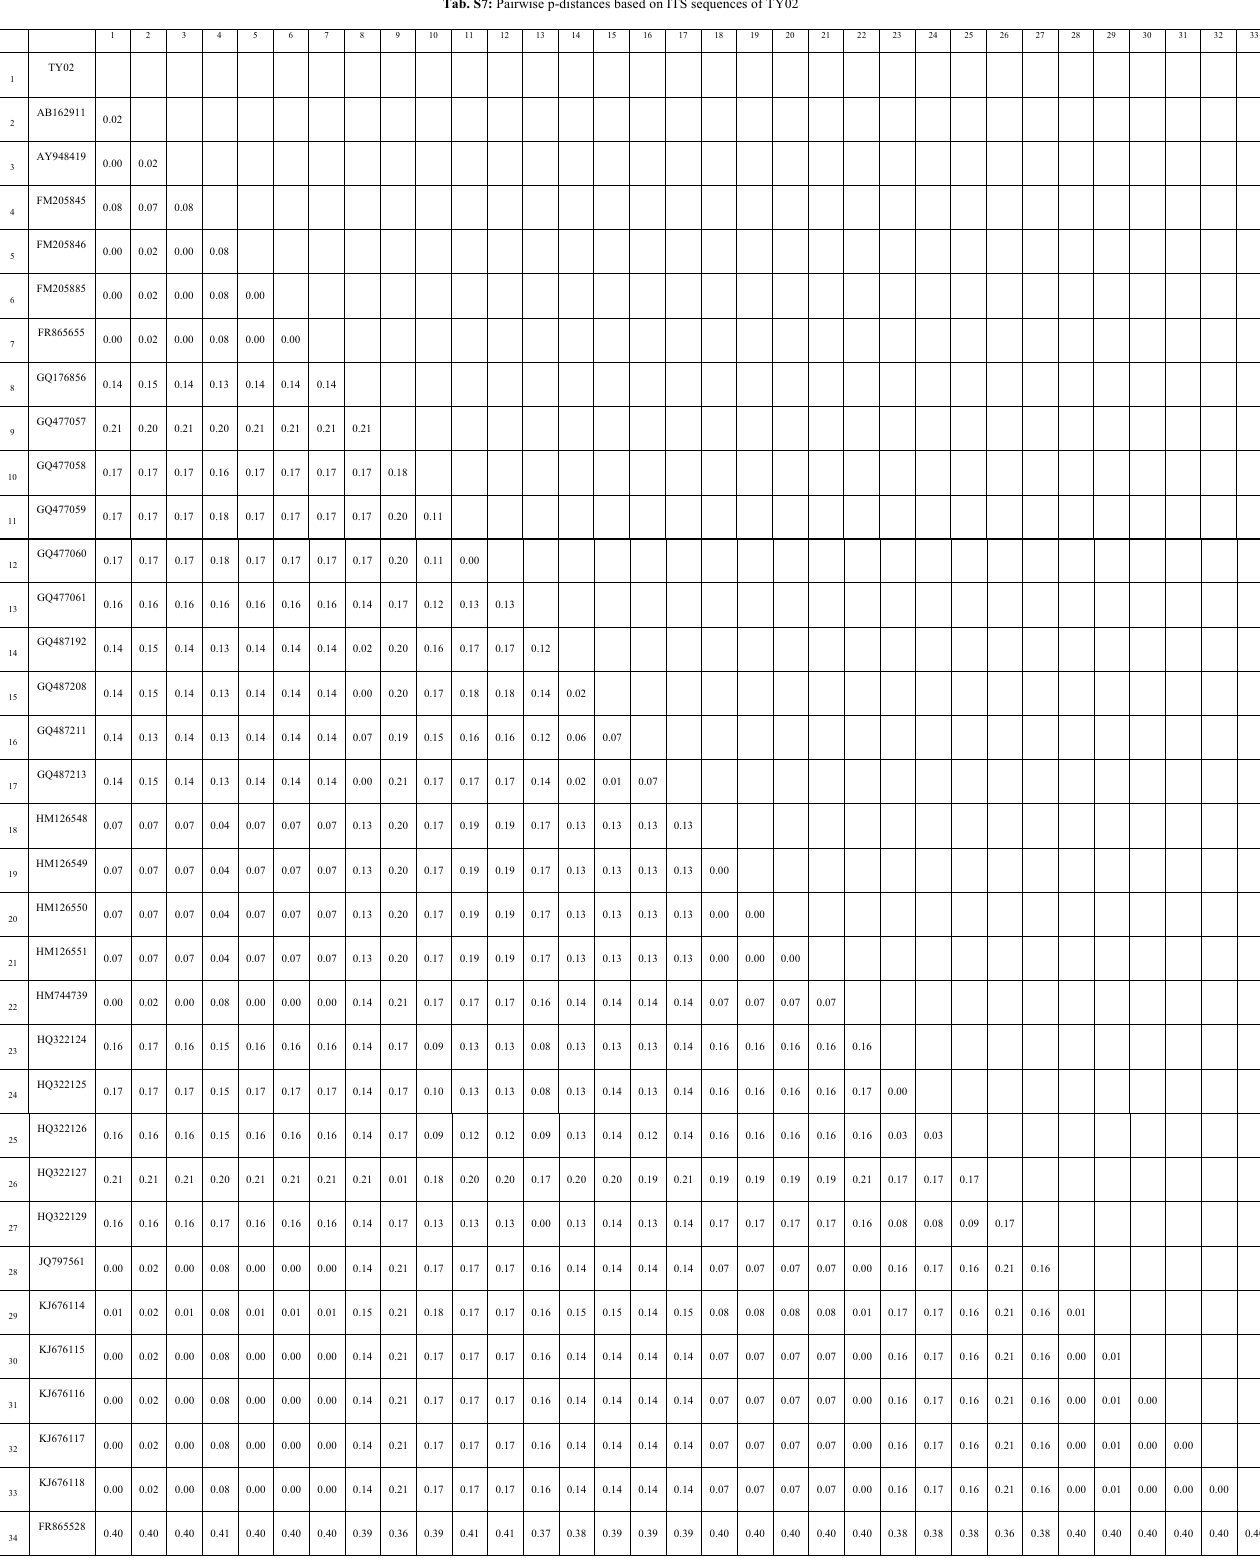
Tab. S7: Pairwise p-distances based on ITS sequences of